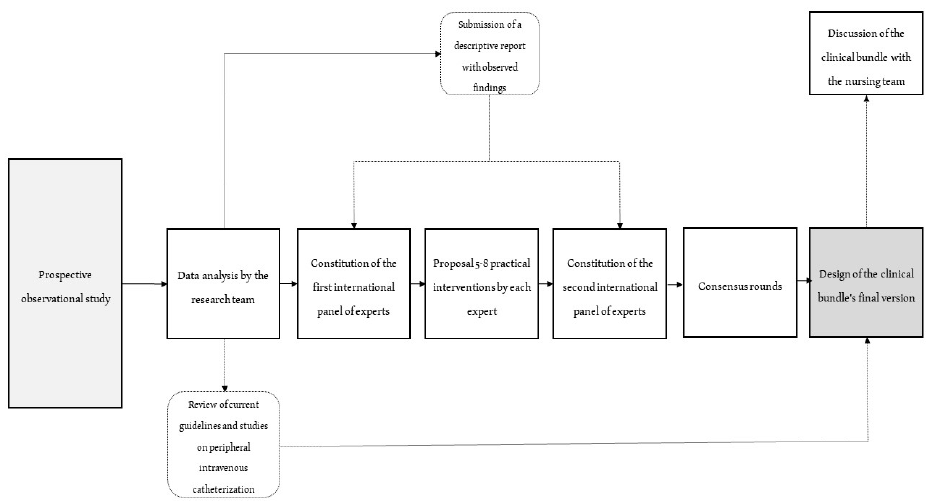
Figure 1. Overall study design.